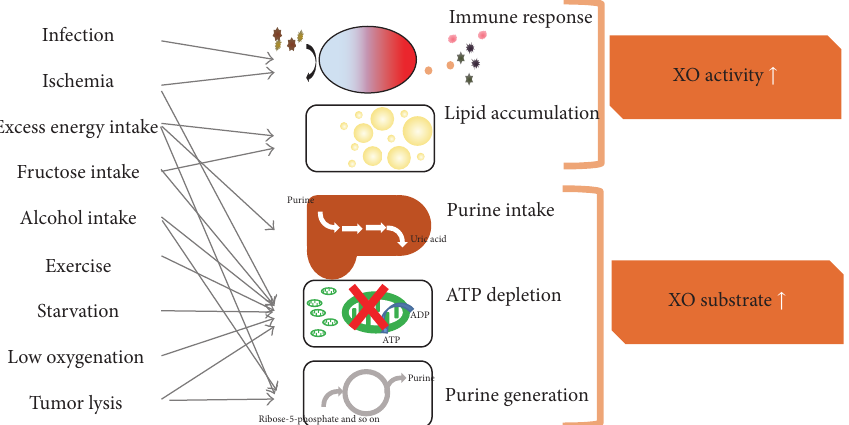
Figure 4: Increased catalyst activity of XO, originating from pathological and physiological events. Involvement of XO in pathophysiological processes suggests applications of XO inhibitors to the treatment of various